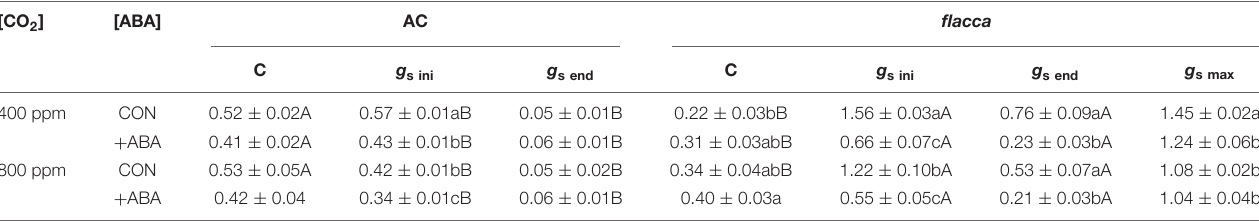
FIGURE 3 | Changes of stomatal conductance ( g s ) in AC (A,B) and flacca (C,D) (total samples = 32–44, N = 3–4) grown under ambient (400 ppm) and elevated (800 ppm) CO 2 concentrations during progressive soil drying. FTSW indicates the fraction of transpirable soil water. CON indicates the control treatment sprayed with water, +ABA indicates exogenous ABA application. TABLE 2 | Output of statistical analysis of parameters derived from the linear-plateau regression of stomatal conductance ( g s ) of AC and flacca under ambient (400 ppm) and elevated (800 ppm) CO 2 concentrations response to the reduction in the fraction of transpirable soil water